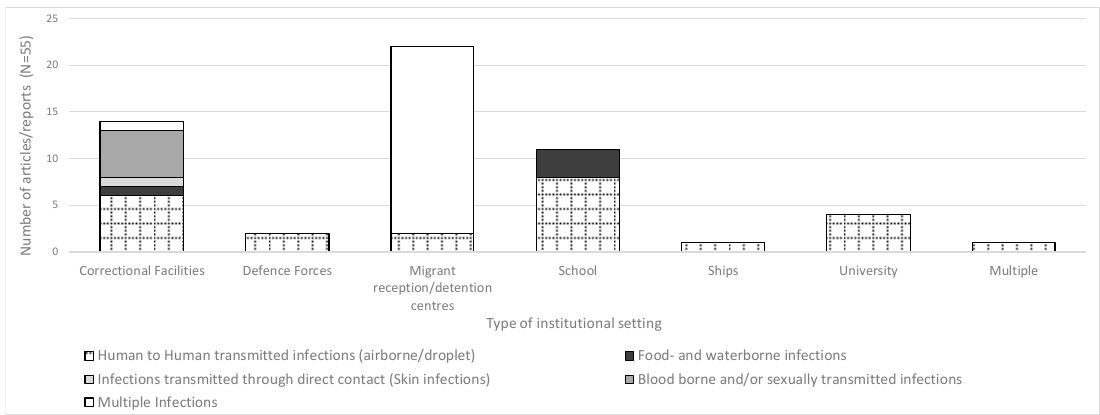
Figure 3. Number of articles or reports addressing the first review objective ( n = 55), by type of infectious disease transmission and setting.